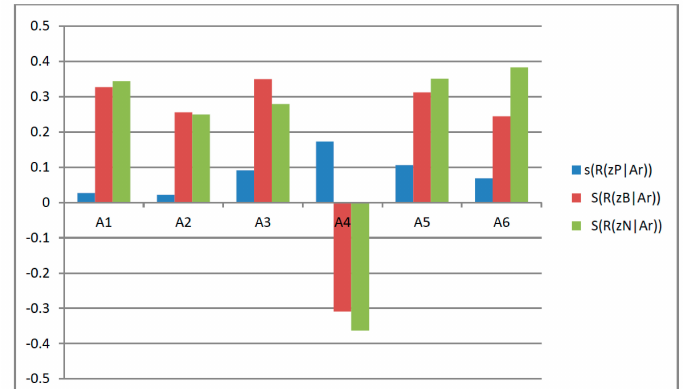
Figure 2. The expected loss score